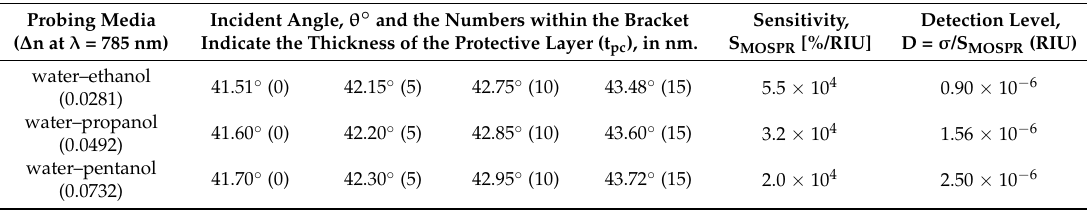
Bracket Indicate the Thickness of the Protective Layer (t pc ), in nm.